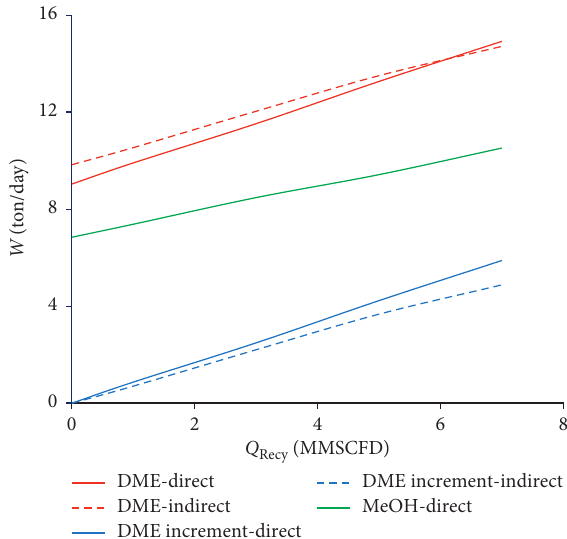
Figure 10: DME and methanol production, W , as a function of the unreacted gas recycle rates, Q Recy .